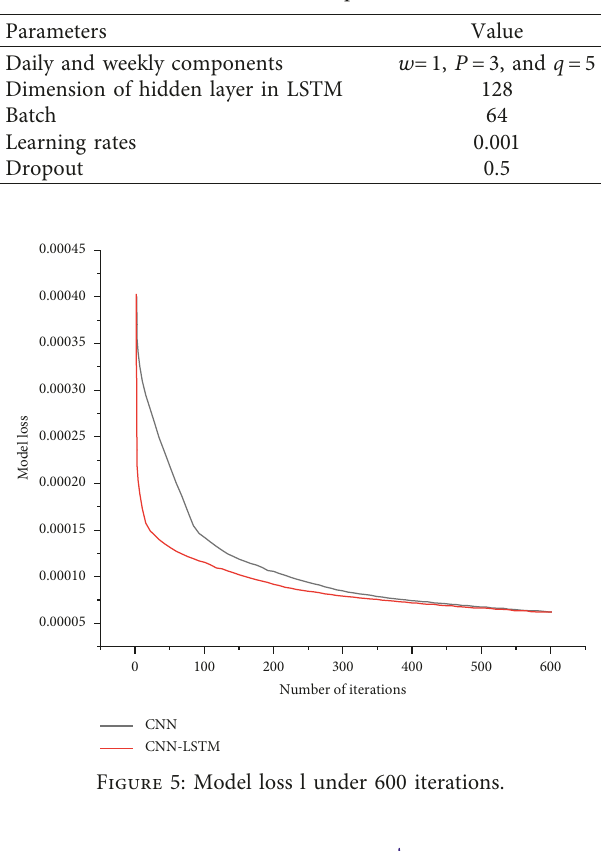
Table 1: Simulation parameters.